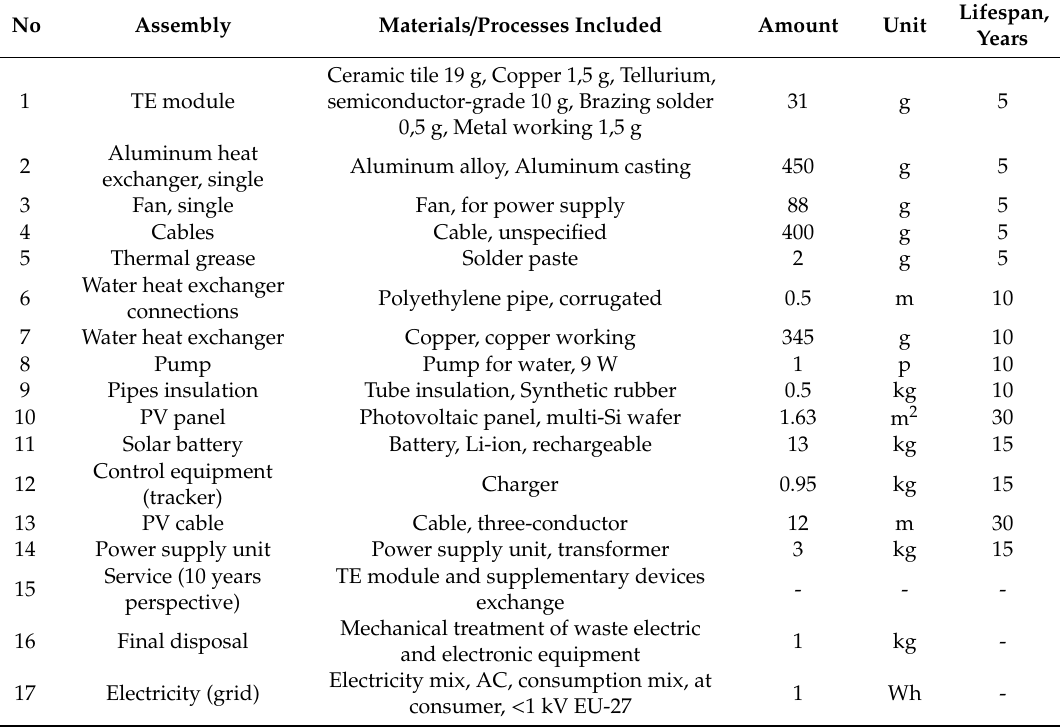
Table A2. Simplified assembly used for assessment of TE cooling system with heat recovery and two supply options (Scenarios 4-6), based on authors’ measurements, calculations, producer data and related processes adopted from